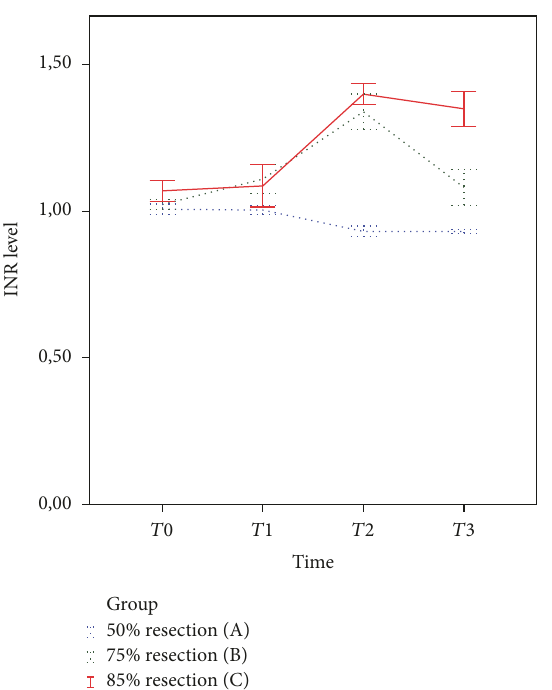
Figure2:Internationalnormalizedratio(INR)levelsatbaselineand after liver resection. 𝑇0 (baseline, 𝑝 = 0.199 ); 𝑇1 (one hour after surgery, 𝑝 = 0.148 ); 𝑇2 (one day after surgery, 𝑝 < 0.001 ); 𝑇3 (at sacrifice, 𝑝 < 0.001 ). INR levels were significantly lower in group A compared with groups B and C ( 𝑝 < 0.001 ) at different time points. Error bars show standard error of the mean.